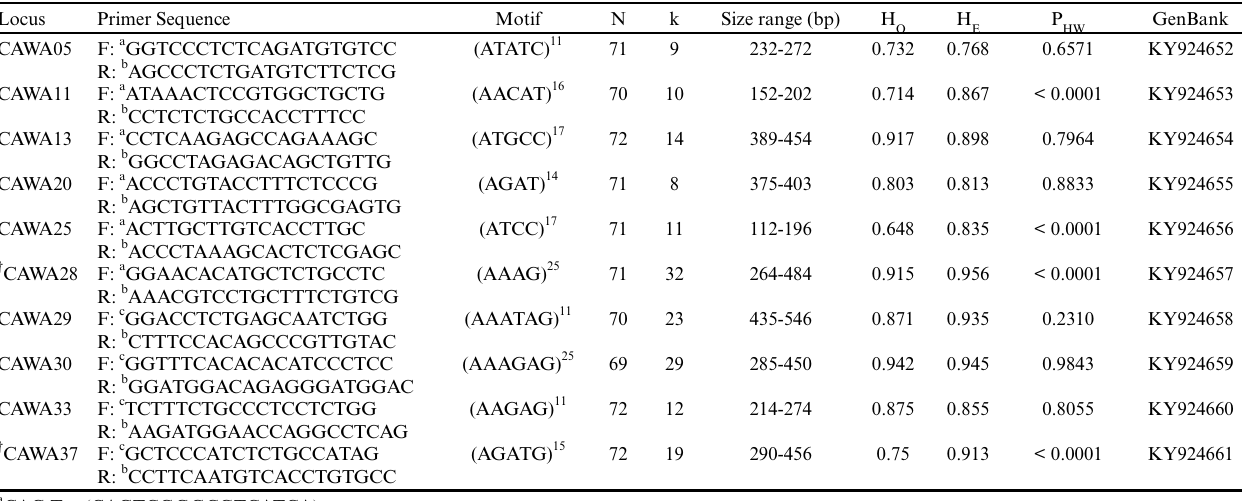
Table 1 . Characterization of microsatellite markers developed for Canada Warblers ( Cardellina canadensis ) tested on samples from a single population in Coweta, North Carolina. N, number of individuals genotyped at each locus; k, number of alleles at each locus; H , observed heterozygosity; H , expected heterozygosity; and P , probability that genotype proportions conform to Hardy-Weinberg O E HW Proportions. GenBank accession numbers are listed for each microsatellite locus